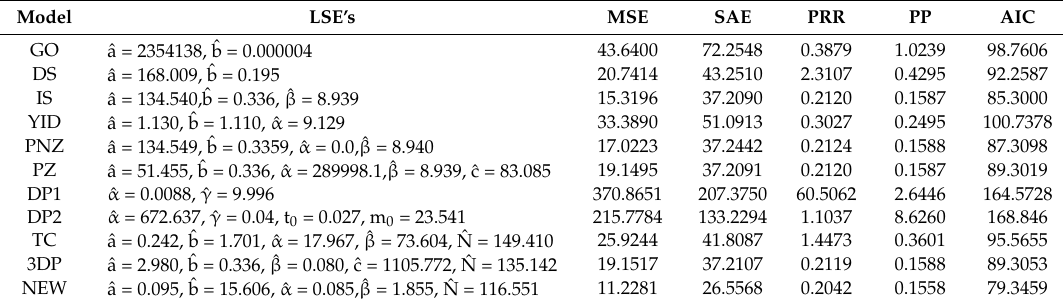
Table 4. Model parameter estimation and comparison criteria from Dataset #1. Least-squares estimate (LSE); mean squared error (MSE); sum absolute error (SAE); predictive ratio risk (PRR), predictive power (PP); Akaike’s information criterion (AIC).